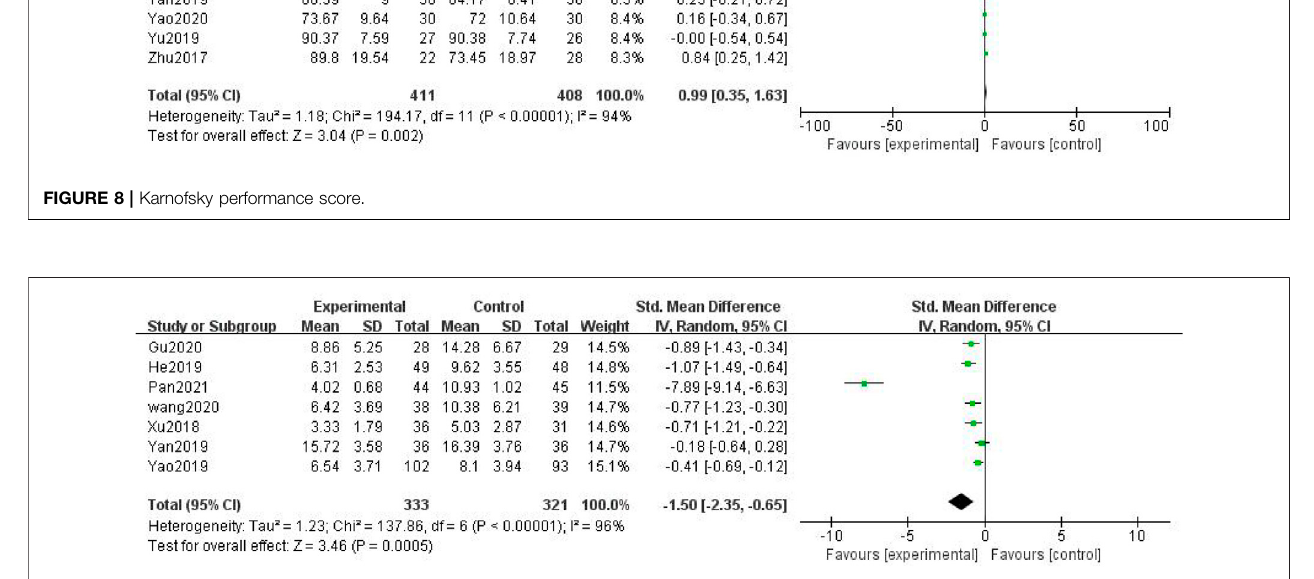
FIGURE 9 | TCM syndrome